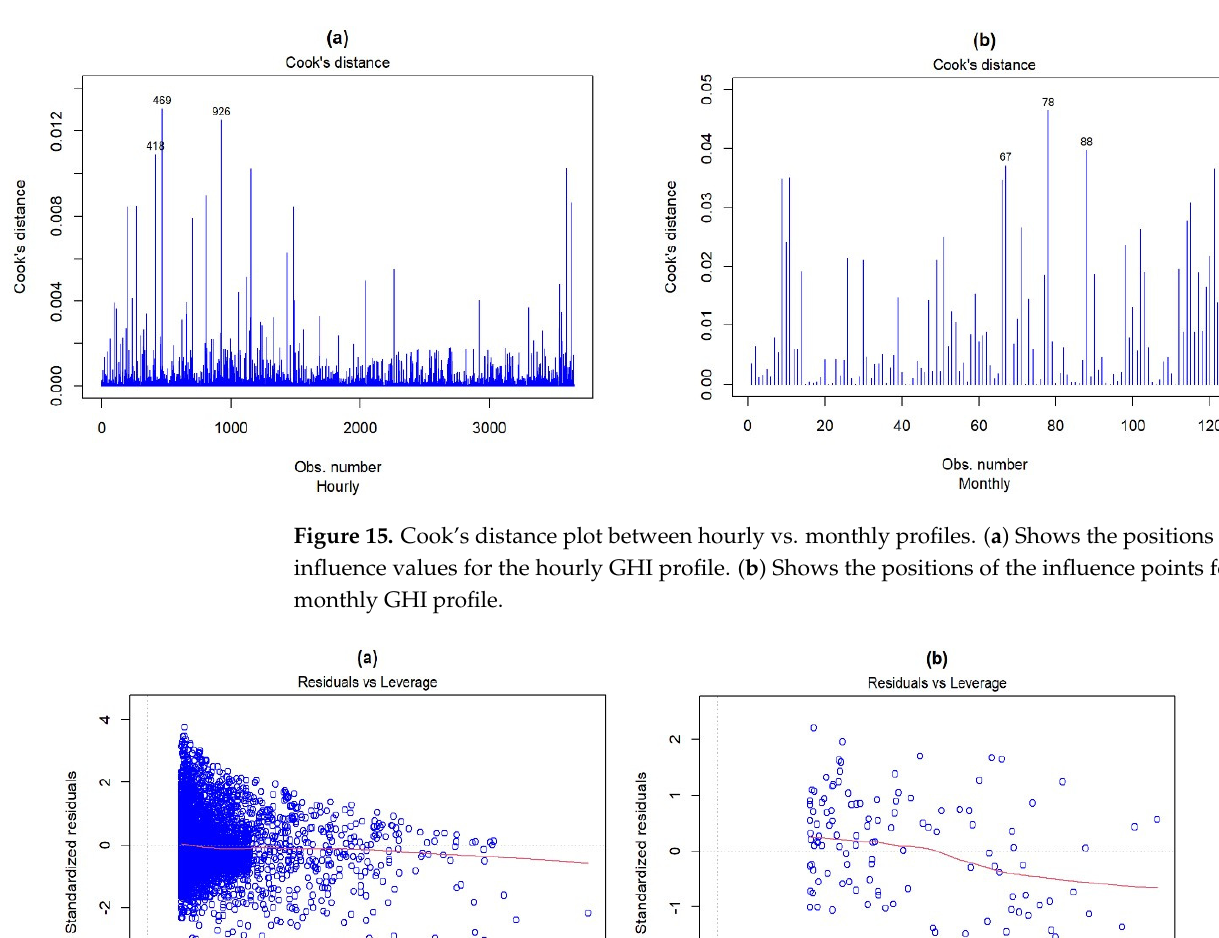
Figure 14. Homoscedasticity scatterplot of the hourly vs. monthly GHI profiles in [W m − 2 ]. ( a ) Shows the variance of the residuals for the hourly GHI profile, while ( b ) shows the variance of the residuals for the monthly GHI profile.